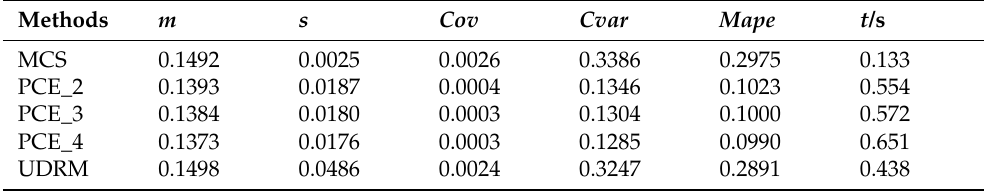
Table 3. Evaluation table of different UQ methods under 50% uncertainty of sheath resistivity under normal